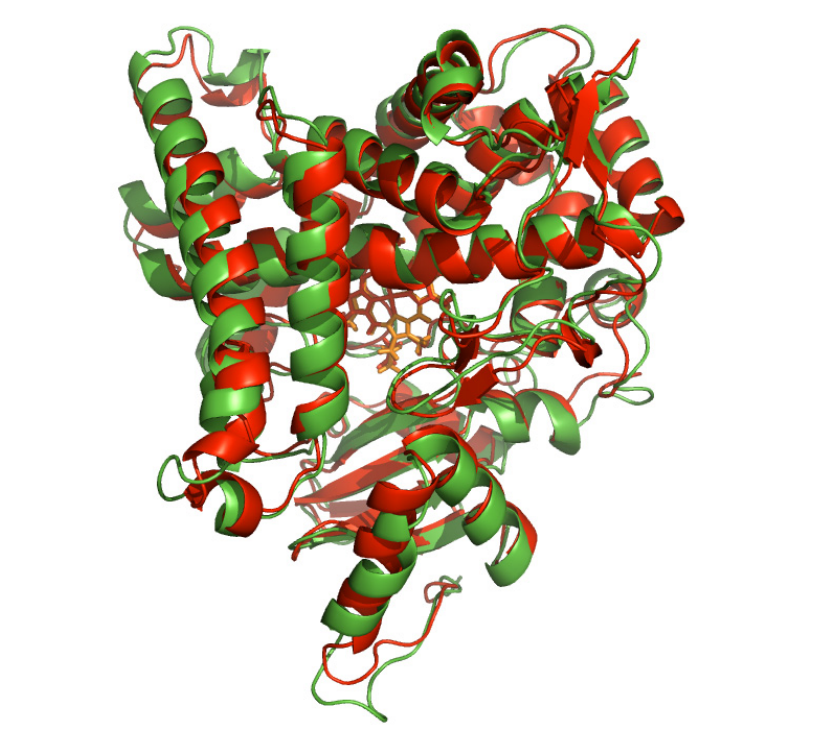
Figure 4. The structural alignment of aromatase at 0 ns (red) and 100 ns